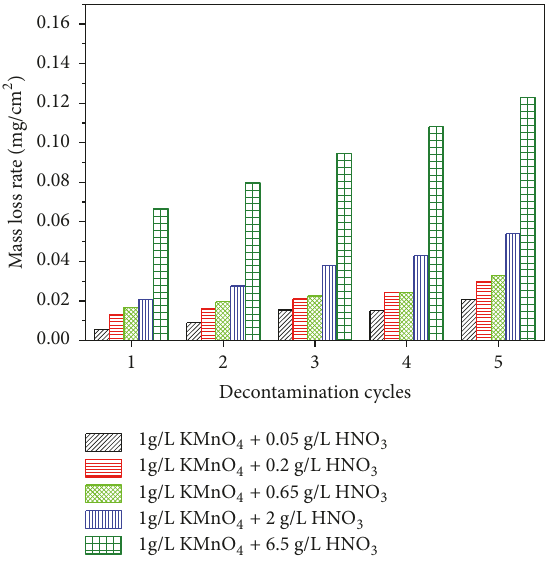
Figure 1: The mass loss of 304L SS carrying out NP-N decontami- nation.